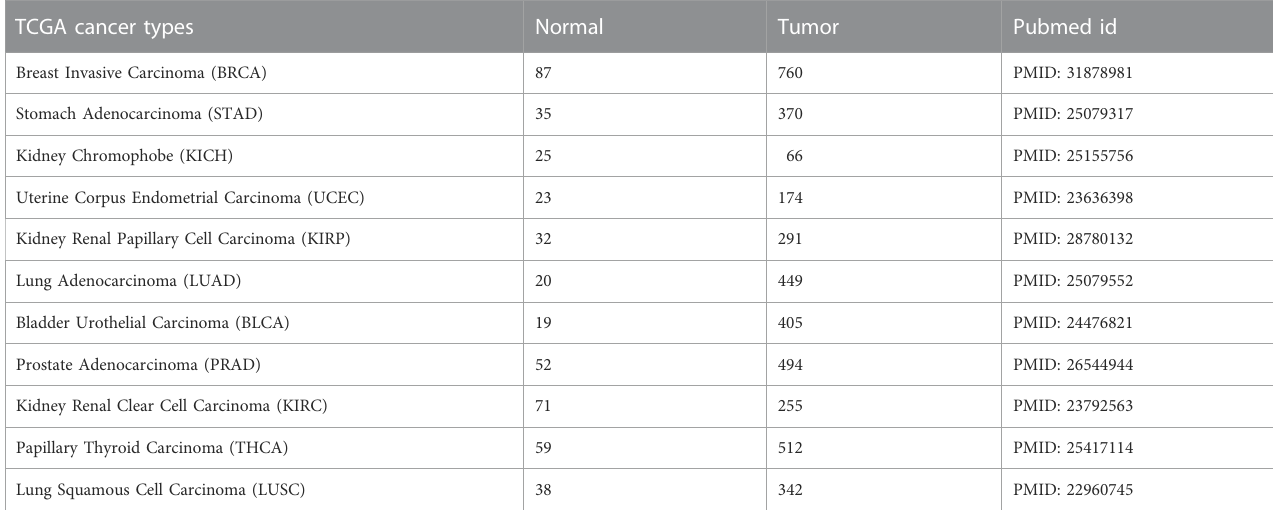
TABLE 2 Details of the TCGA datasets used in